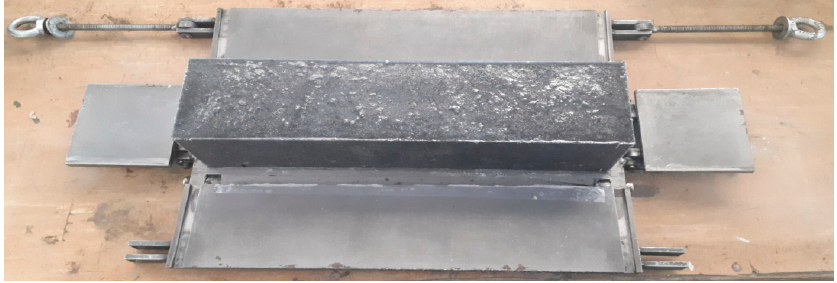
Figure 4. The casting from the mold.